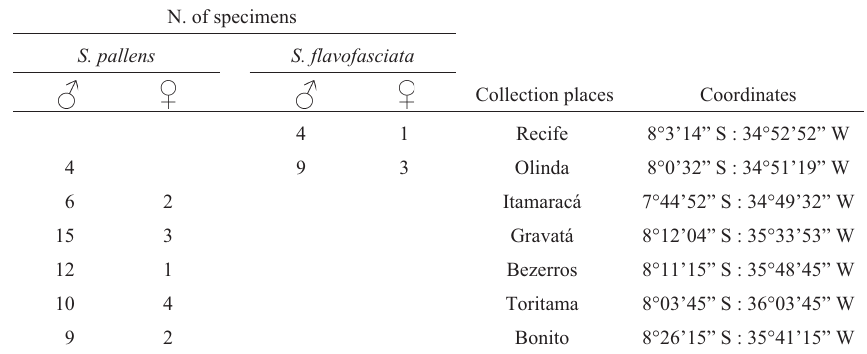
Table 1 - Specimens of Schistocerca pallens and S. flavofasciata analyzed, collection places and geographical